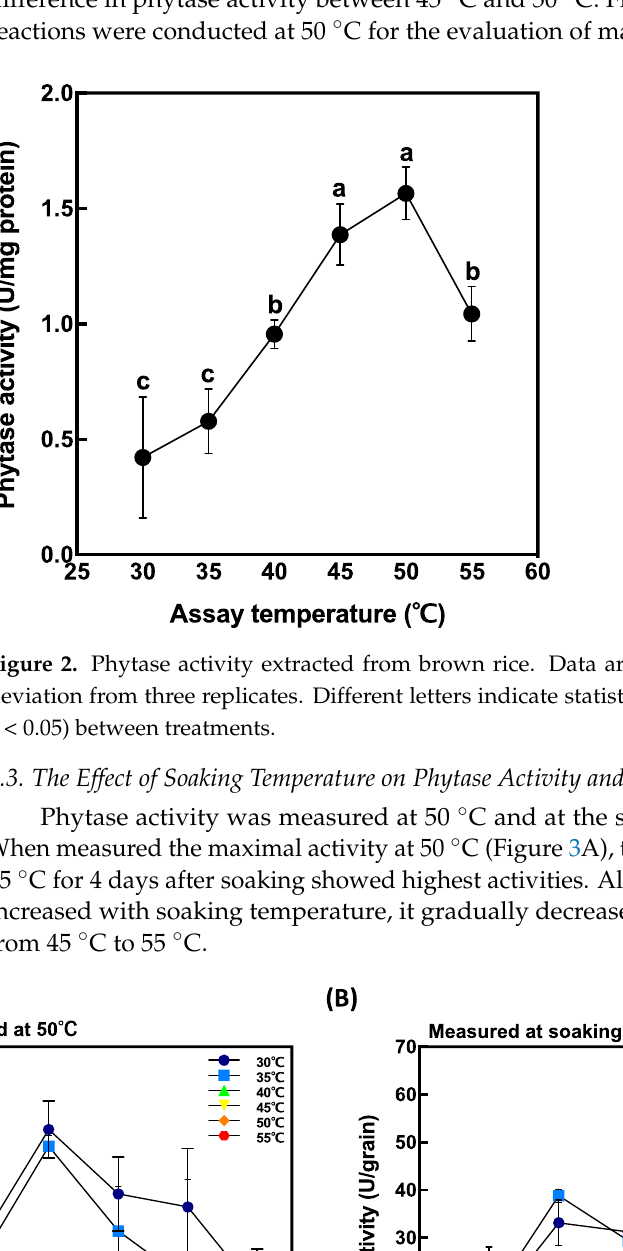
Figure 1. Effect of temperature on germination. ( A ) 30 °C, ( B ) 35 °C, ( C ) 40 °C, ( D ) 45 °C, ( E ) 50 °C, and ( F ) 55 °C.